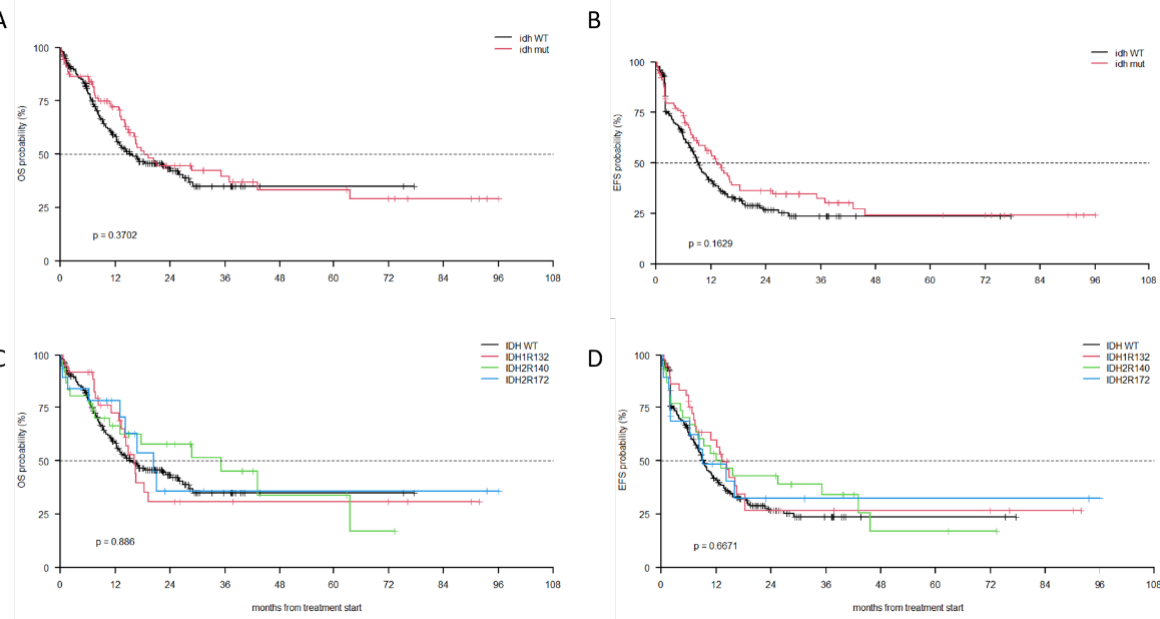
Figure 2. ( A ) OS by IDH1/2 mutations; ( B ) EFS by IDH1/2 mutations; ( C ) OS by the most frequent IDH1/2 mutations; ( D ) EFS by the most frequent IDH1/2 mutations.